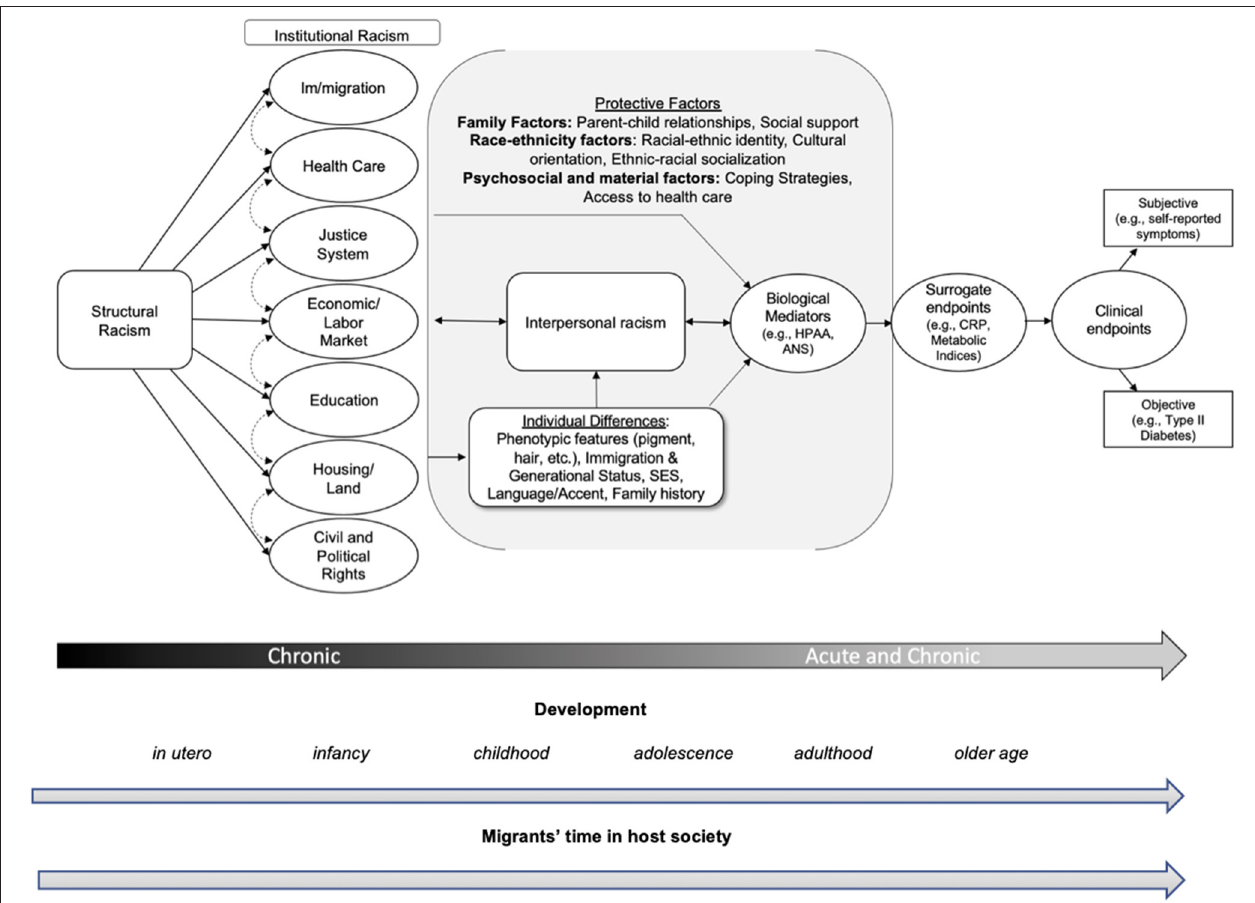
FIGURE 1 | Structural, institutional, and interpersonal racism’s effects on biological mediators, surrogate endpoints, and clinical endpoints. This figure demonstrates how structural and institutional racism shape the context in which interpersonal racism occurs. Individual differences are shaped by structural racism, as the meanings for phenotypes in relation to white supremacy, cultural representations of race, racism, and Latinidad are shaped by the structure. Moreover, Latinx life chances, such as their educational attainment and health status, are shaped by the structure. Individual differences in phenotypic features, immigration status, generational status (e.g., first generation), socioeconomic status, language use (indigenous, Spanish, etc.), family history of disease, and accent also shape the ways that structural and institutional racism form experience of interpersonal racism for diverse Latinx persons. Individual differences also influence experience of interpersonal racism from experience. For example, lighter-skinned Latinx person without an accent may not experience interpersonal racism as intensely as a darker-skinned Latinx person. Individual differences, such as family history of disease also play a moderating role on biological mediators, biological surrogates, and clinical endpoints. Dependent on the context and outcomes of interest, these individual differences can directly or indirectly impact the discriminatory experience a Latinx person faces, as well as moderate the link between racism and clinical endpoints. Acute and chronic stress emanating from (a) cultural, environment, and economic deprivation resulting from structural and institutional racism, and (b) experience of interpersonal racism have physiological effects on the body, which manifest as biological mediators [e.g., HPA axis, ANS; see page. 12 of the article and (104)] and surrogate endpoints (e.g., metabolic indices). Over time, as a Latinx child becomes older or an immigrant lives longer in their host society, racial chronic stress can lead to adverse health outcomes and their subsequent clinical endpoints. Protective factors such as familial (e.g., parent-child relationships, social support), race-ethnicity (e.g., identity, cultural orientation, ethnic-racial socialization), and psychosocial and material factors (e.g., coping strategies, health care access), may buffer the impact of structural and institutional racism on biological mediators, which may decrease the likelihood of the development of surrogate endpoints and subsequent subjective (e.g., self-reported depression symptoms) and/or objective (e.g., Type II diabetes) clinical endpoints. The line at the bottom represents time—acute (moments of interpersonal racism) vs. chronic racial stress through ones life course. The institutions capture under structural racism were adapted from Bailey et al. (46) and the biological mediators, surrogate and clinical endpoints were adopted from Robles et al.